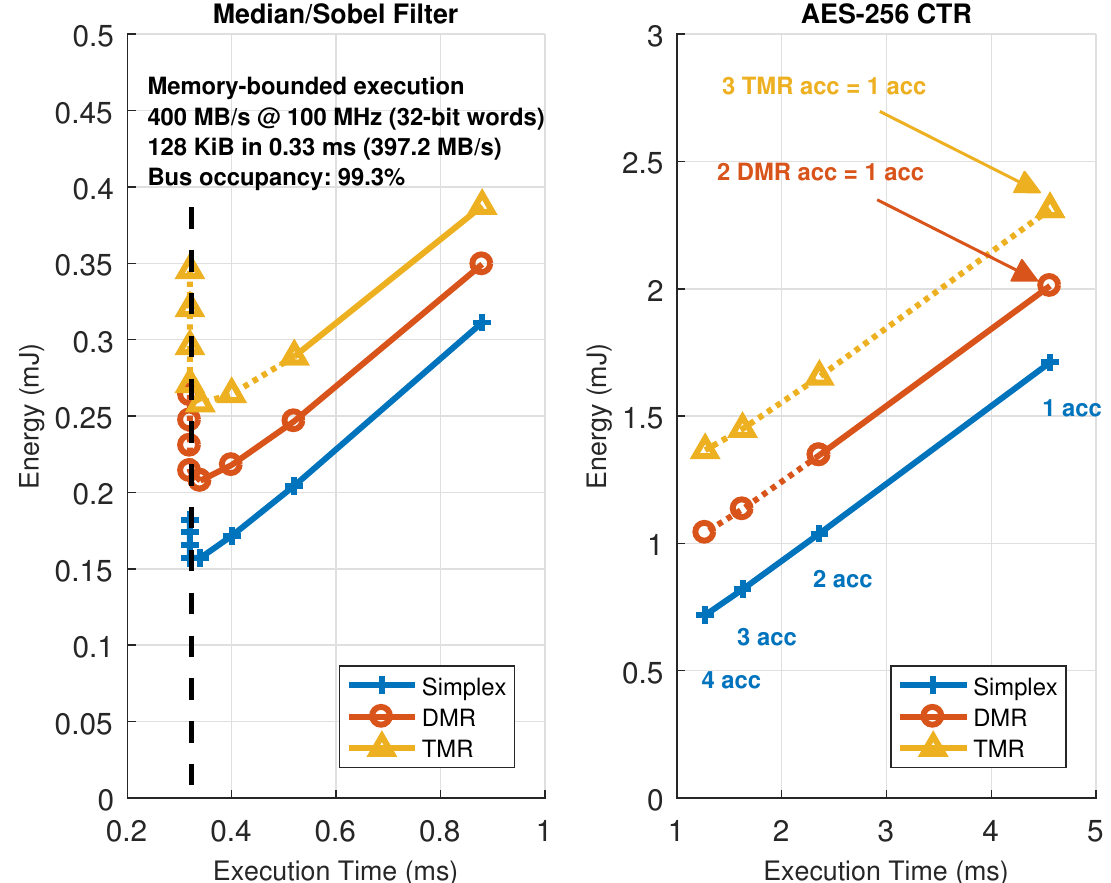
Figure 12. Solution space exploration in the HiReCookie node for memory-bounded (image filters, left ) and computing-bounded (block cipher, right ) algorithms.